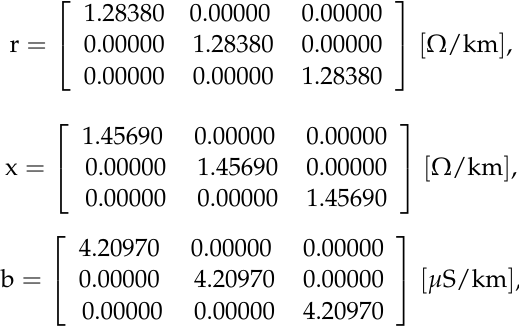
326 327 328 329 330 331